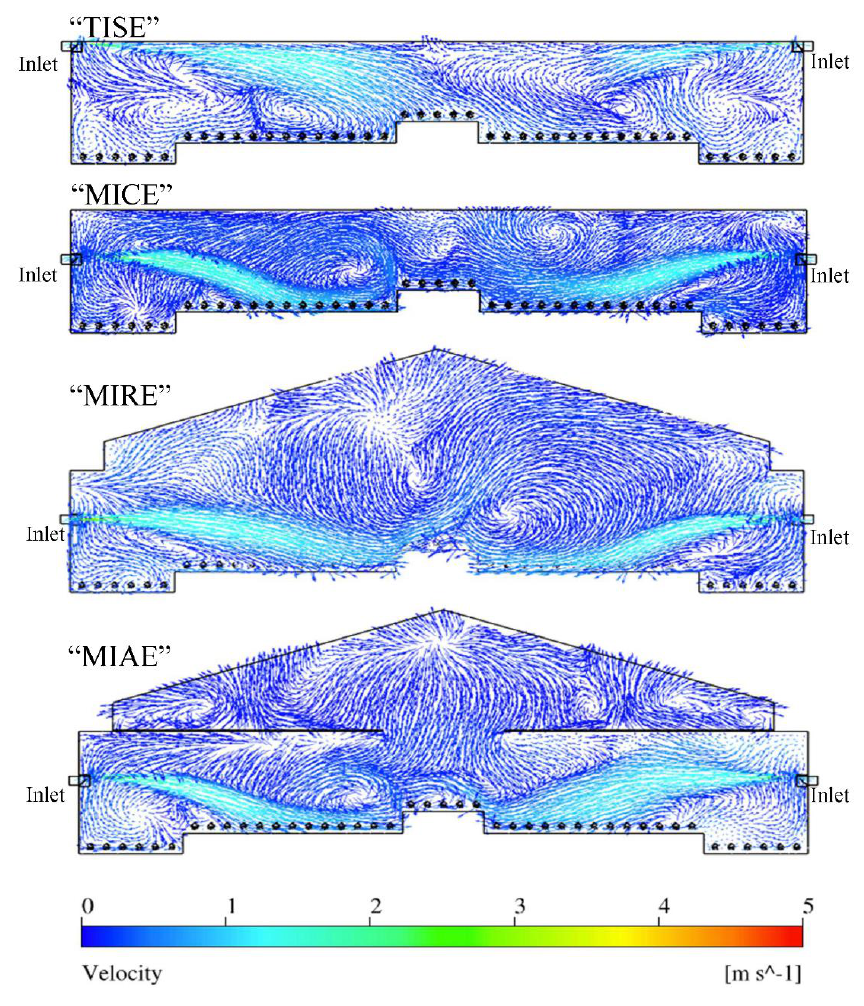
Figure 6. Indoor air velocity vector contours at Plane I of four models.